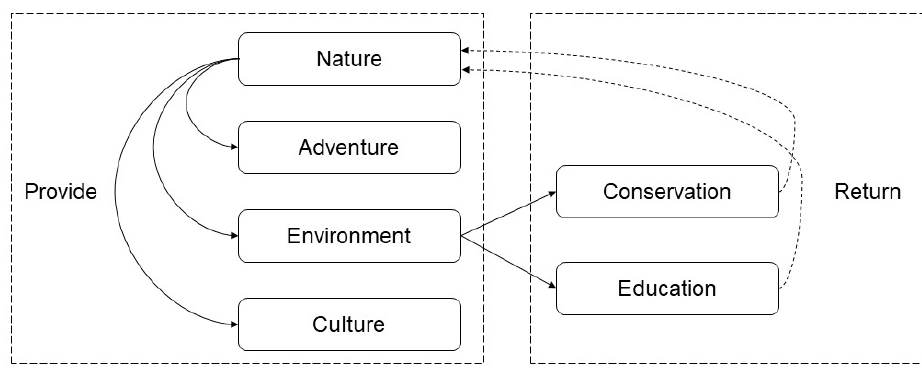
Figure 4. Proposed Tourists’ SoP